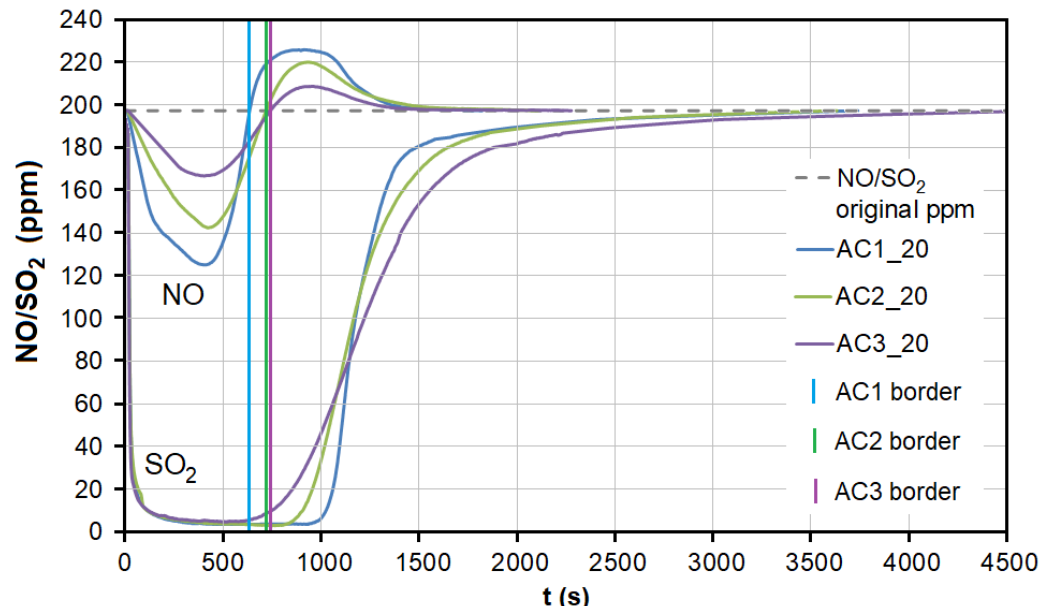
Figure 7. The dependence between SO 2 adsorption and NO desorption at the temperature of 20 °C. AC1, AC2, and AC3 border lines represent the beginning of the NO desorption effect for each adsorbent. AC1-3—activated carbon at different granulometric fractions (see Table 1). At the temperature of 20 °C, a total of 214.32/92.66 μg/g of NO was adsorbed/desorbed on AC1, 163.92/60.86 μg/g on AC2, and 106.51/30.03 μg/g on AC3 (Figure 8). This phenomenon was investigated in more detail using molecular dynamics (see Section 3.3). Forced desorption was not observed with any other adsorbent. while the SO 2 adsorption maximum of SO 2 occurred immediately after the EG flow started (Figure 9). The same was observed during SO 2 adsorption on CL, SiO 2 and CEL (Figures 10 and